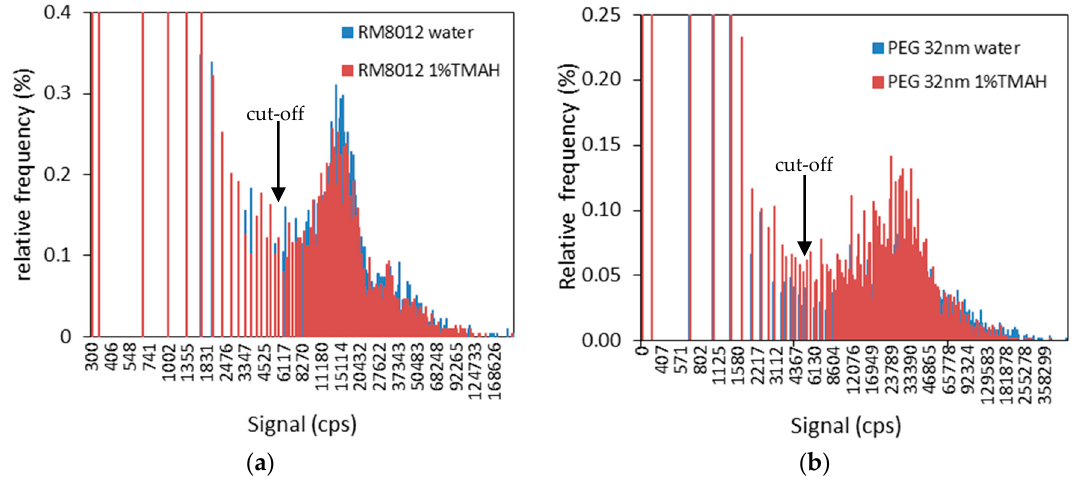
Figure 3. Histogram of signals obtained with a 5 ms dwell time in ultrapure water and 1% TMAH matrix for ( a ) NIST RM8012 and ( b ) PEGylated 32 nm gold nanoparticles suspensions.